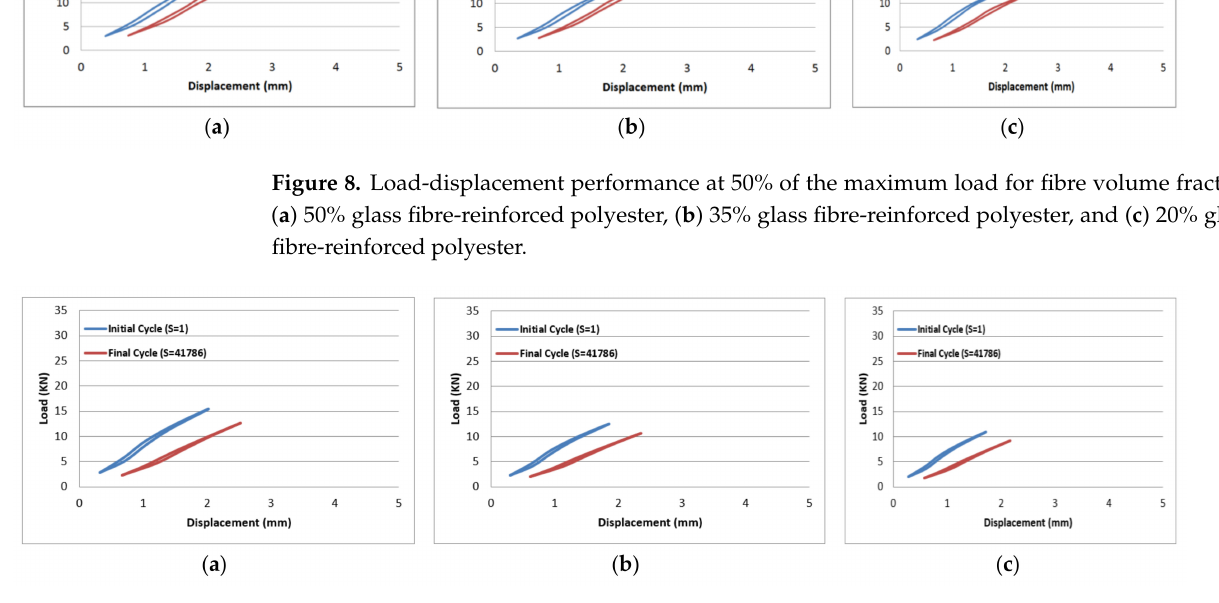
Figure 9. Load-displacement performance at 40% of the maximum load for fibre volume fraction ( a ) 50% glass fibre-reinforced polyester, ( b ) 35% glass fibre-reinforced polyester, and ( c ) 20% glass fibre-reinforced polyester.